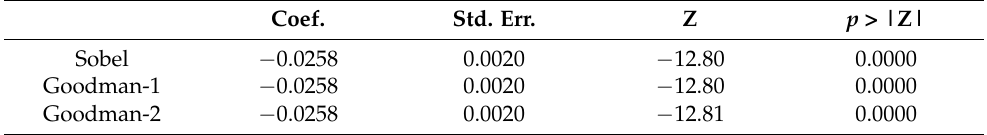
Table 3. Sobel-Goodman mediation tests.